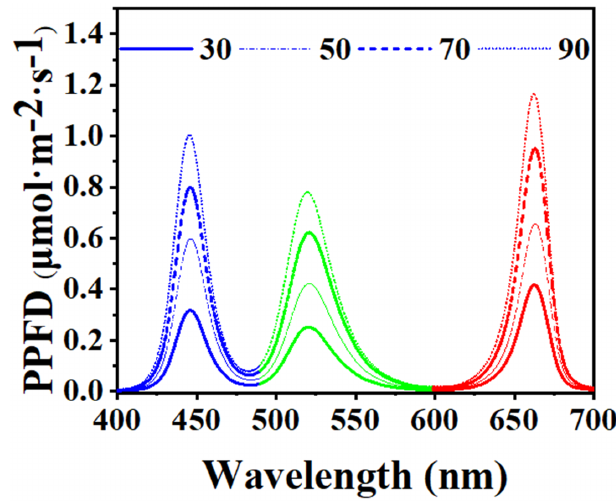
Figure 2. Light spectra of light treatment.